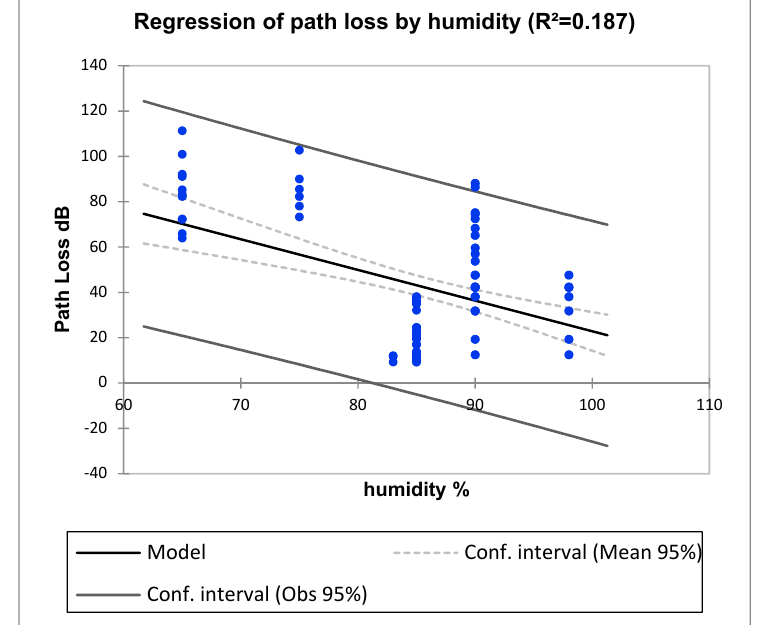
Figure 6. Regression of Path Loss by Humidity.